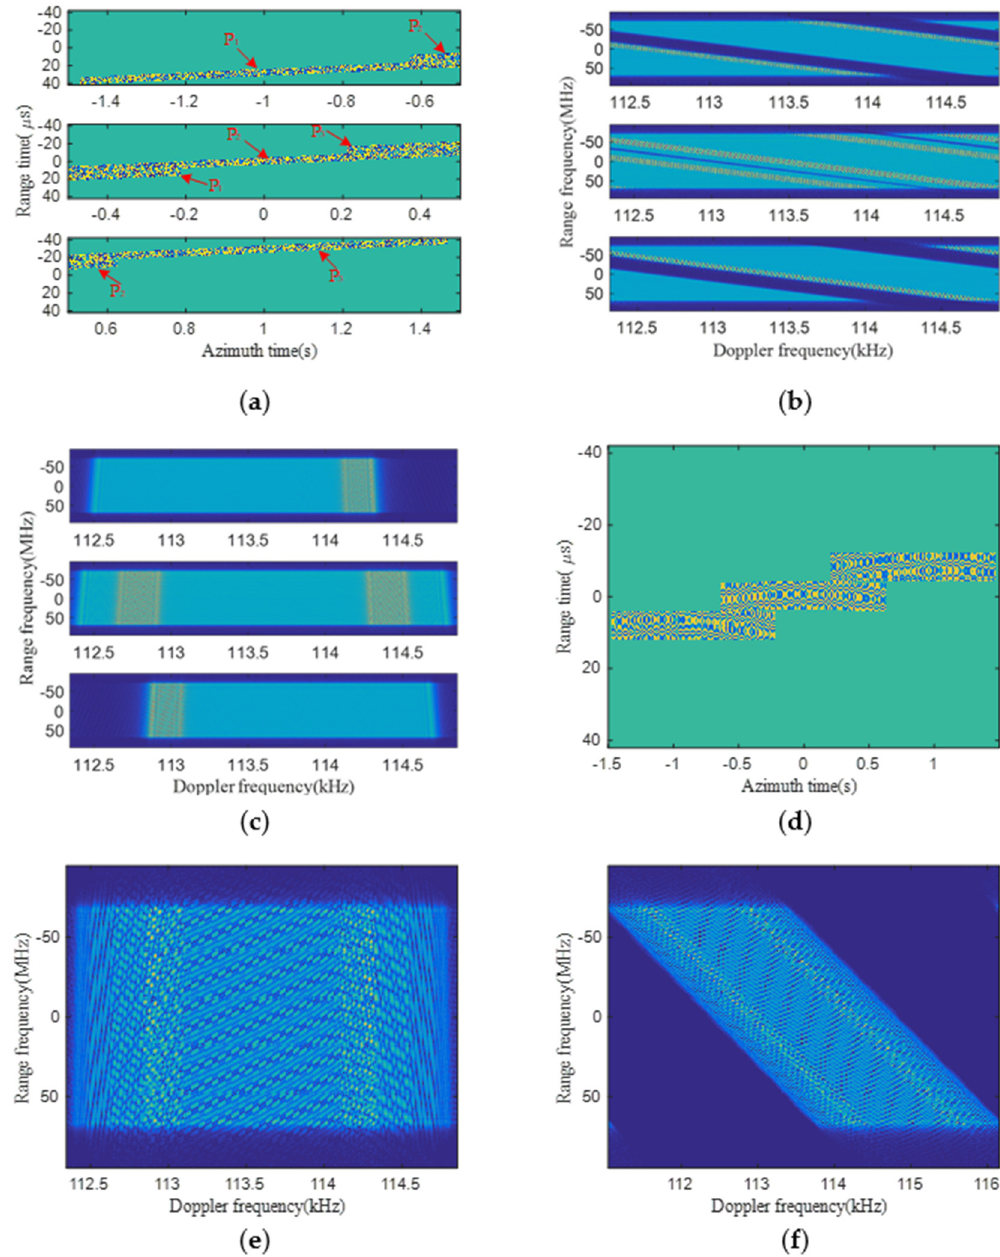
Figure 16. Simulation results of the proposed method. ( a ) The real part of echo data in three blocks; ( b ) 2-D spectra of ( a ); ( c ) 2-D spectra in three blocks before azimuth combination; ( d ) echo data of the whole imaged scene after azimuth combination; ( e ) 2-D spectrum of ( d ) before re-skewing; ( f ) the recovered 2-D